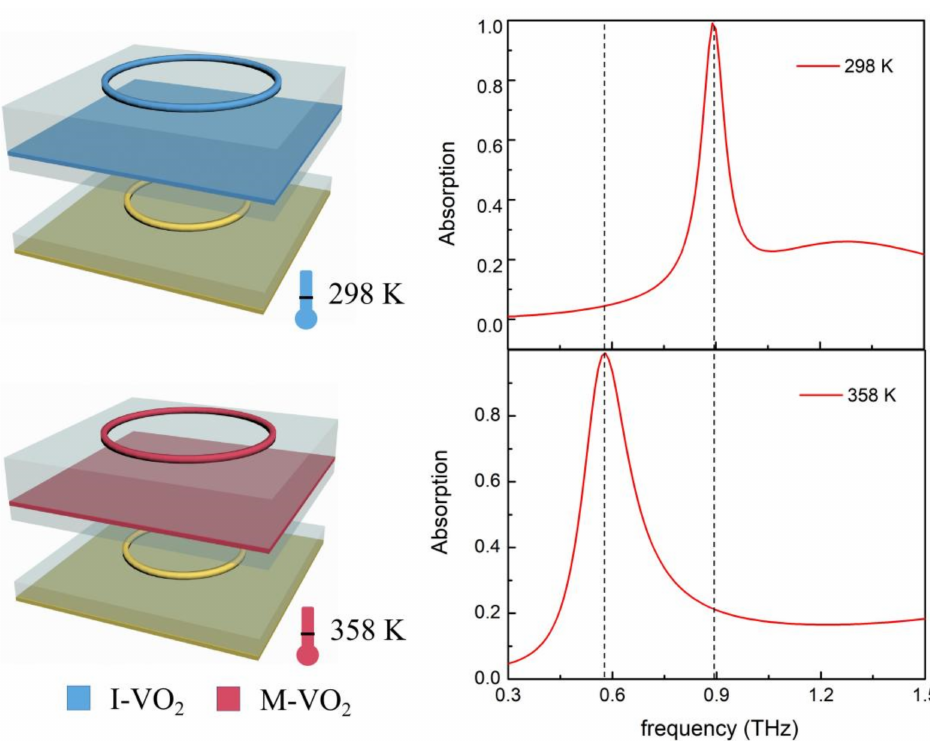
Figure 2. Absorption spectral characteristics of the thermally switchable absorber at 298 K and 358 K. I-VO 2 represents the insulator state VO 2 , and M-VO 2 represents the metallic state VO 2 . In order to further investigate the underlying mechanism of the thermally switchable absorption spectrum, as shown in Figure 3, we calculated the electric field distribution at the absorption peaks in the VO 2 -ring array layer when the VO 2 was in the insulator state (indicated by V layer) and the electric field distribution in the Au-ring array layer when the VO 2 was in a dielectric state (indicated by A layer). Obviously, at room temperature (VO 2 in dielectric state), the electric fields were mainly confined at the edge of the Au-rings, and the V layer showed no obvious field confinement. Similarly, at high temperature (VO 2 in the dielectric state), the electric fields were mainly confined at the edge of the VO 2 -rings. The results show that the upper and lower sandwiched cavity structure can work independently via thermally switching the phase state of the VO 2 ; thus, the two working modes can be independently designed and